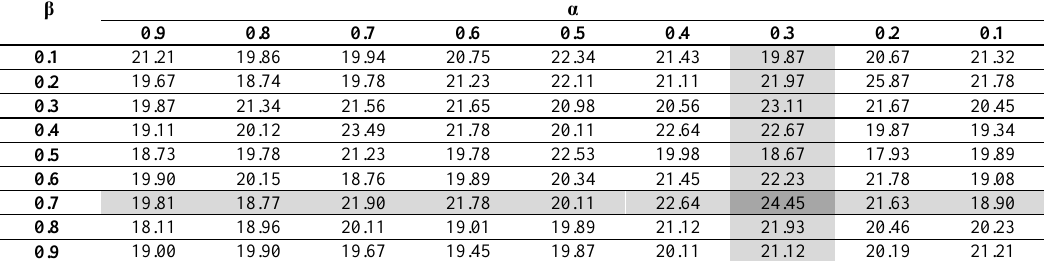
Table 1. Pearson values for α and